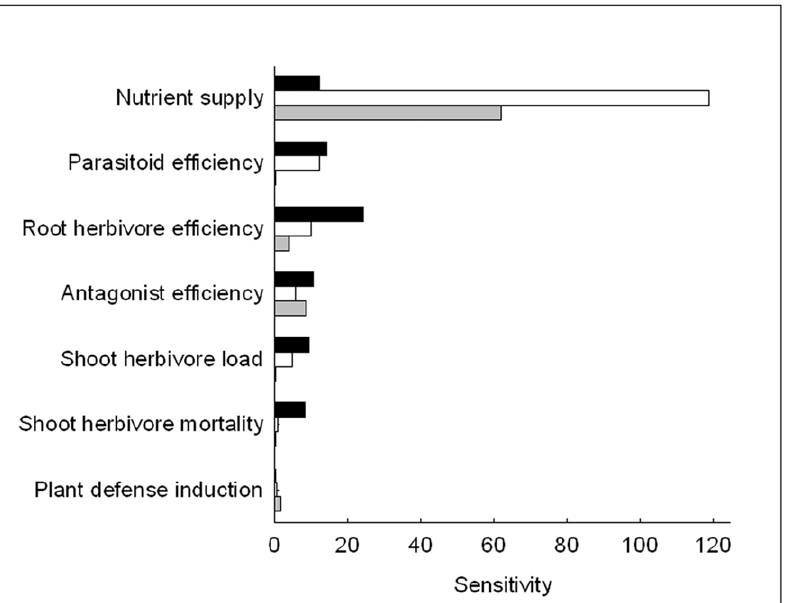
Figure 1. Sensitivity of model outputs to parameters of the land use intensity gradient. The model outputs were plant mortality (solid bars), average shoot biomass (empty bars), and average root biomass (grey bars). Sensitivity was derived from linear models of the form output , gradient parameter * removal scenario for all possible combinations of outputs and gradient parameters. Sensitivity was calculated as the regression slope of the parameter divided by the corresponding standard error for standardization.